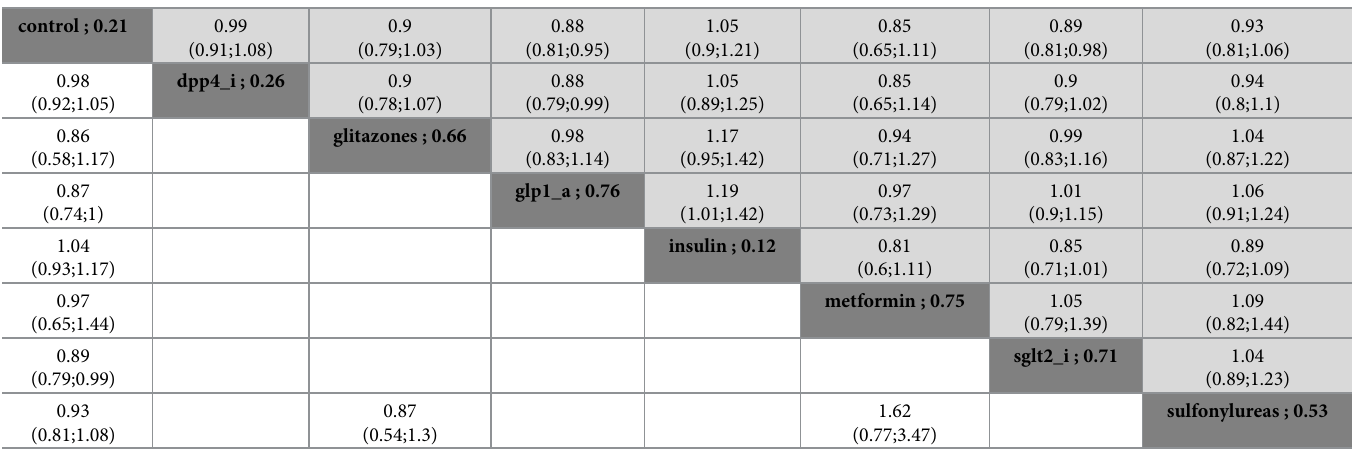
Table 4. Treatment effect estimates for major adverse cardiovascular events